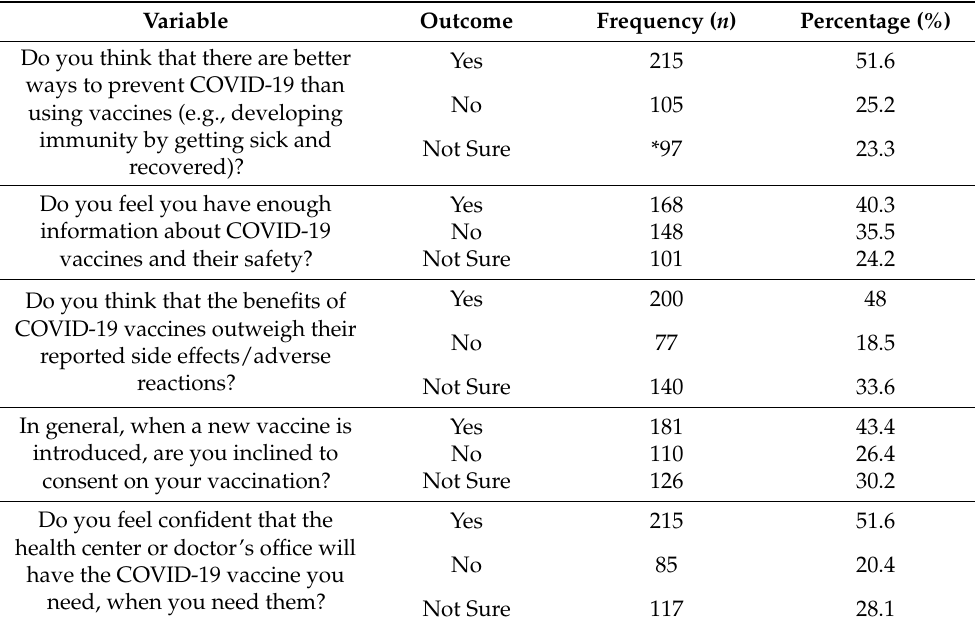
Table 5. Behaviors of Palestinian dental students towards COVID-19 vaccine, February—March 2021 ( n =